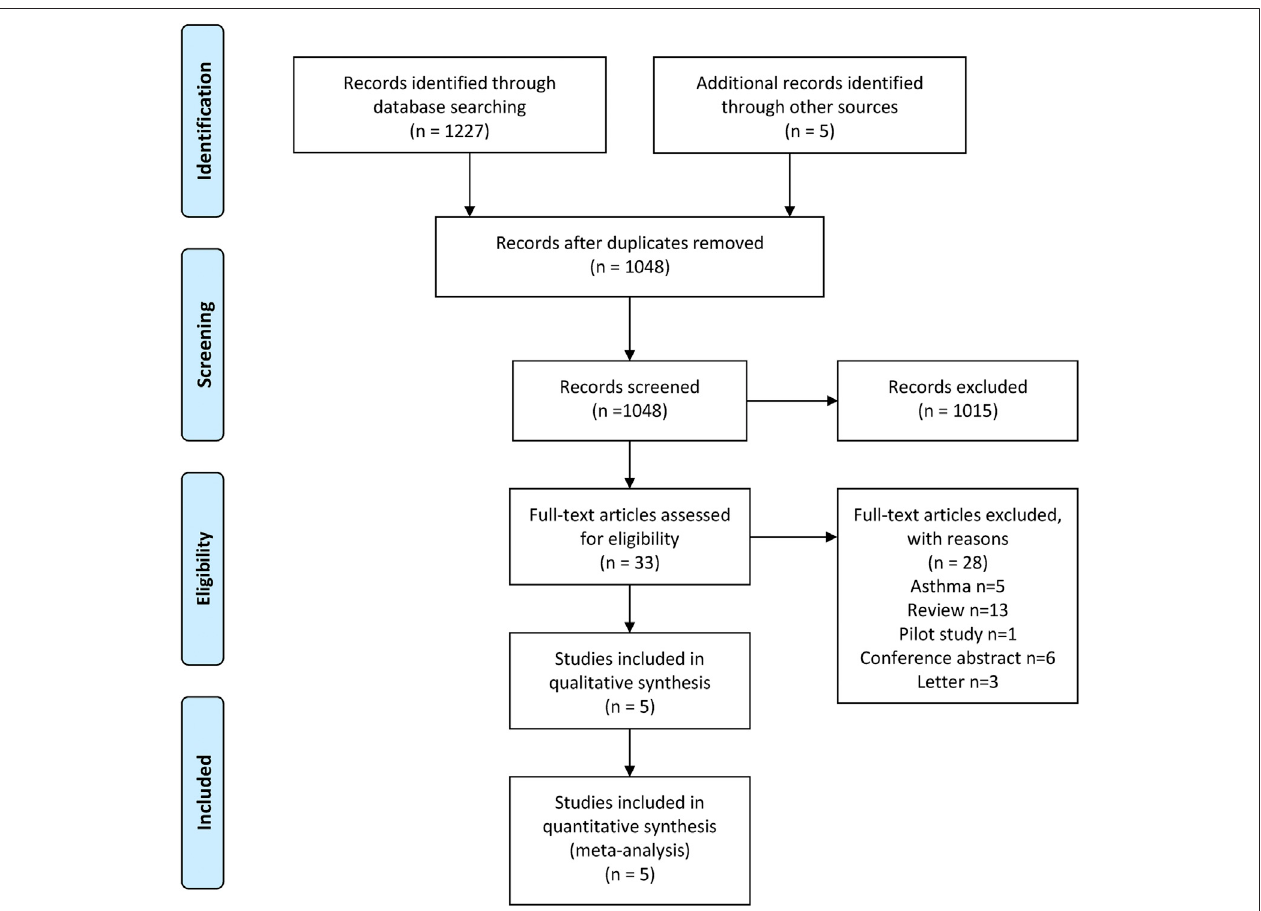
FIGURE 1 | Study selection process: PRISMA fl ow diagram identifying studies included in the meta-analysis. PRISMA, Preferred Reporting Items for Systematic Reviews and Meta-Analyses.